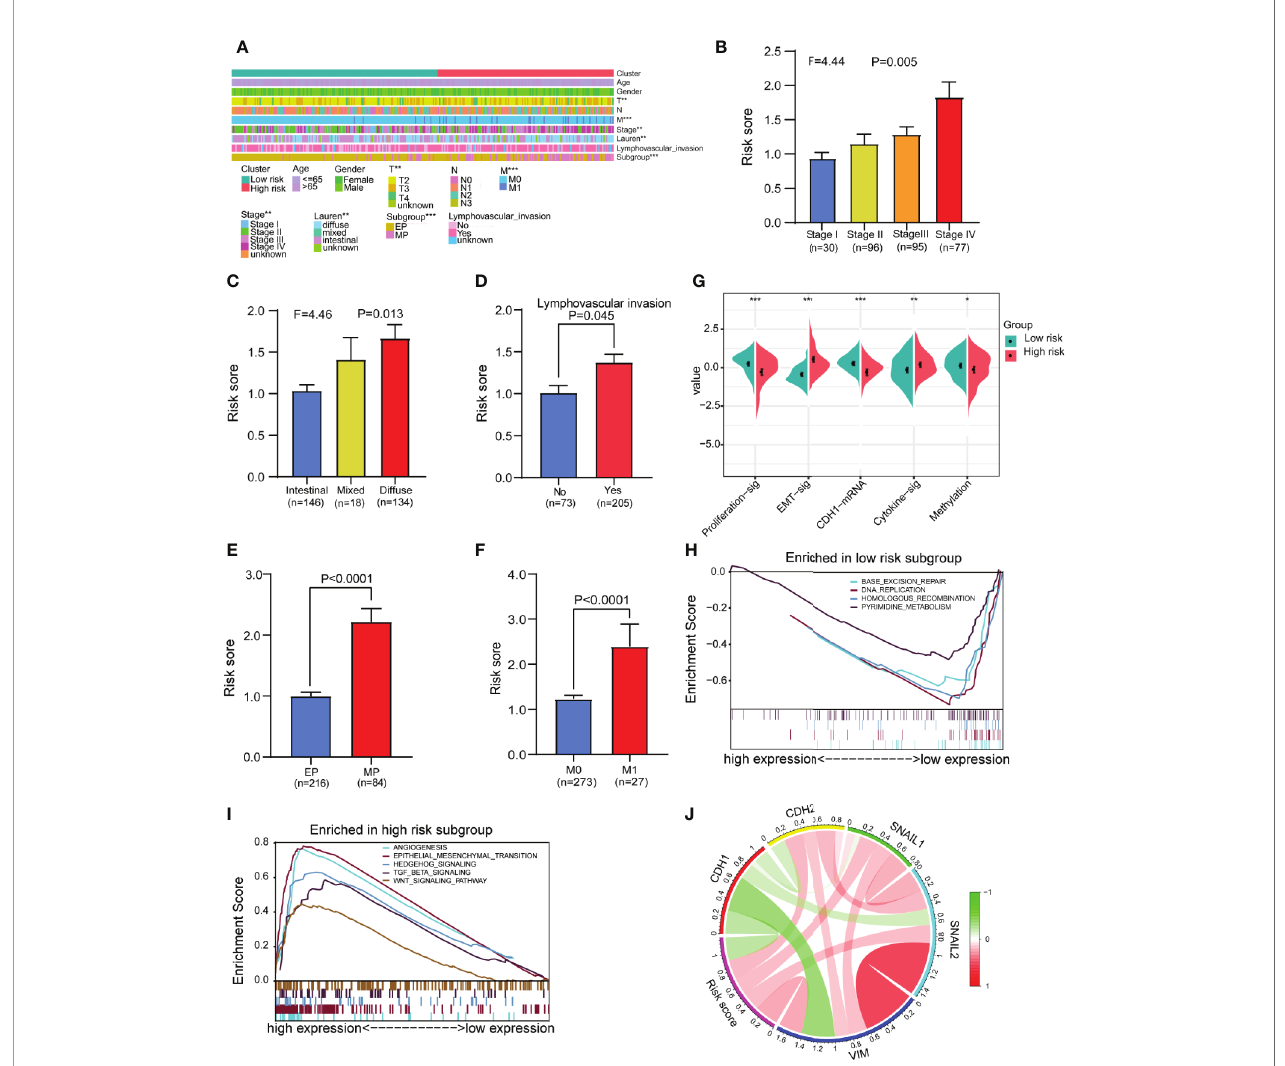
FIGURE 6 | Analysis of differences in clinical characteristics and functional enrichment of patients in different risk groups. (A) The distributions of clinicopathological features were compared between the low-risk and high-risk groups (high-risk n = 138, low-risk n = 162 chi-square test). (B, C) Comparison of the risk scores of patients with different clinical stages and Lauren types (one-way analysis of variance). (D) Comparison of risk scores between patients with negative and positive lymphatic invasion status (Student ’ s t-test). (E) Comparison of the risk score of patients with epithelial phenotype (EP) and mesenchymal phenotype (MP) subtypes (Student ’ s t-test). (F) Comparison of the risk score of patients with no metastasis (M0) and metastasis (M1) (Student ’ s t-test). (G) Comparison of the different molecular signatures in the high- and low-risk groups (high-risk n = 138, low-risk n = 162 Student ’ s t-tests). (H) Gene set enrichment analysis (GSEA) in the low-risk group (n = 162, permutation tests P < 0.05, FDR < 0.25). (I) Gene set enrichment analysis (GSEA) in the high-risk group (n = 138, permutation tests P < 0.05, FDR < 0.25). (J) Analysis of the correlation between the risk score and EMT marker expression in gastric cancer patients (Pearson correlation coef fi cient). Data for (A – J) are from the GSE62254 dataset. Signi fi cant difference between the two groups: *P < 0.05; **P < 0.01; ***P <